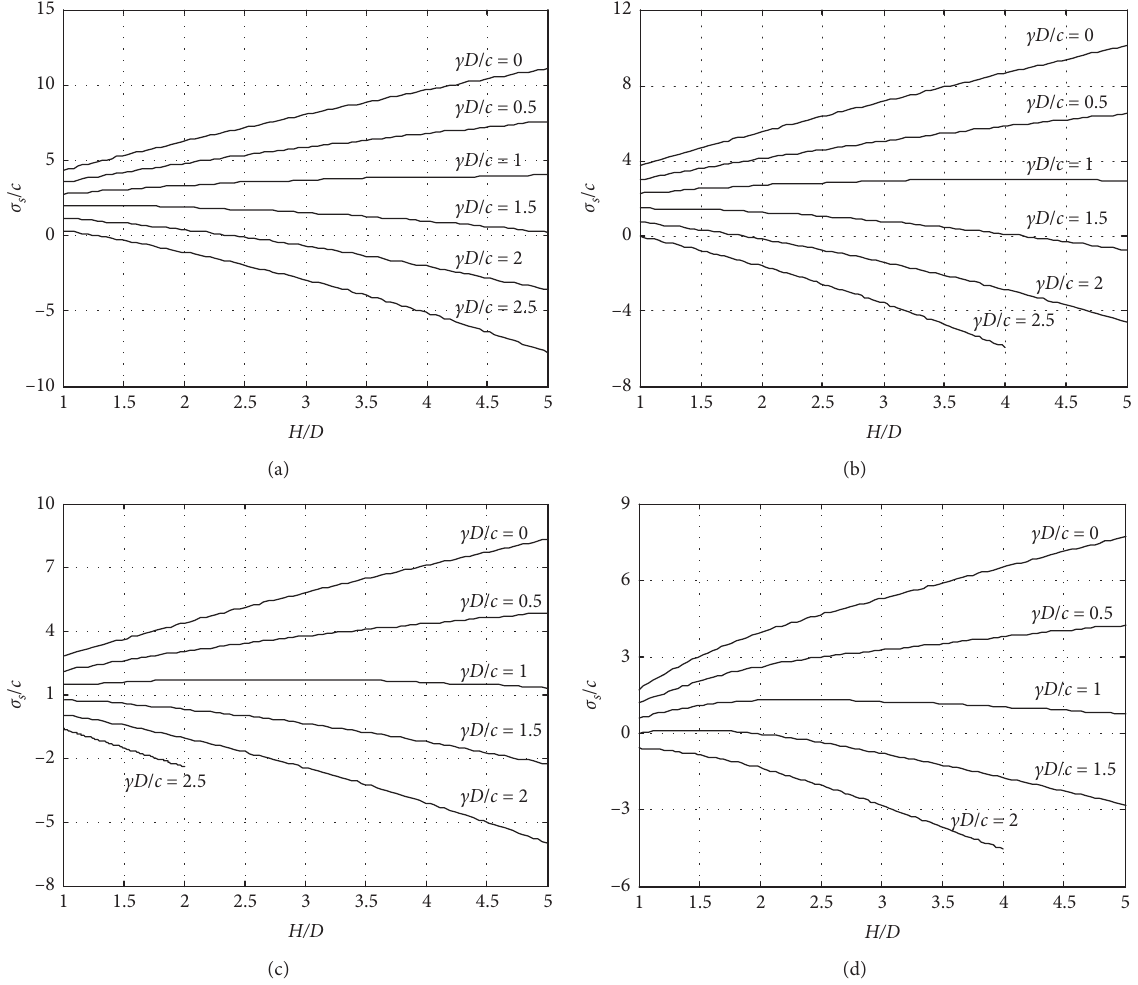
Figure 2: Stability numbers for rectangular tunnels ( φ � 10 ° ). (a) B / D � 0.5. (b) B / D � 0.75. (c) B / D � 1.25. (d) B / D �